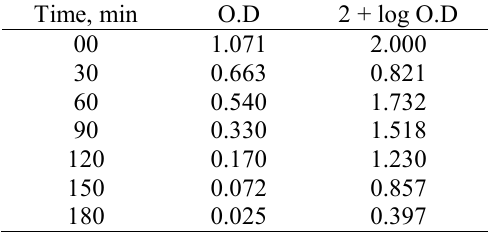
Table 1. A Typical Run- Dye = 1.5 x 10 -4 M/L, Photocatalyst = 50 mg.